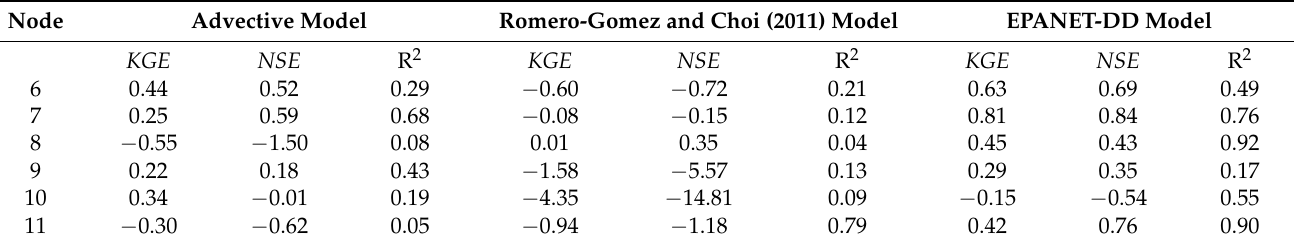
Table 6. Comparison of statistical parameters (Kling–Gupta efficiency, Nash–Sutcliffe efficiency, R 2 ) for the advective, Romero-Gomez and Choi (2011) and EPANET-DD